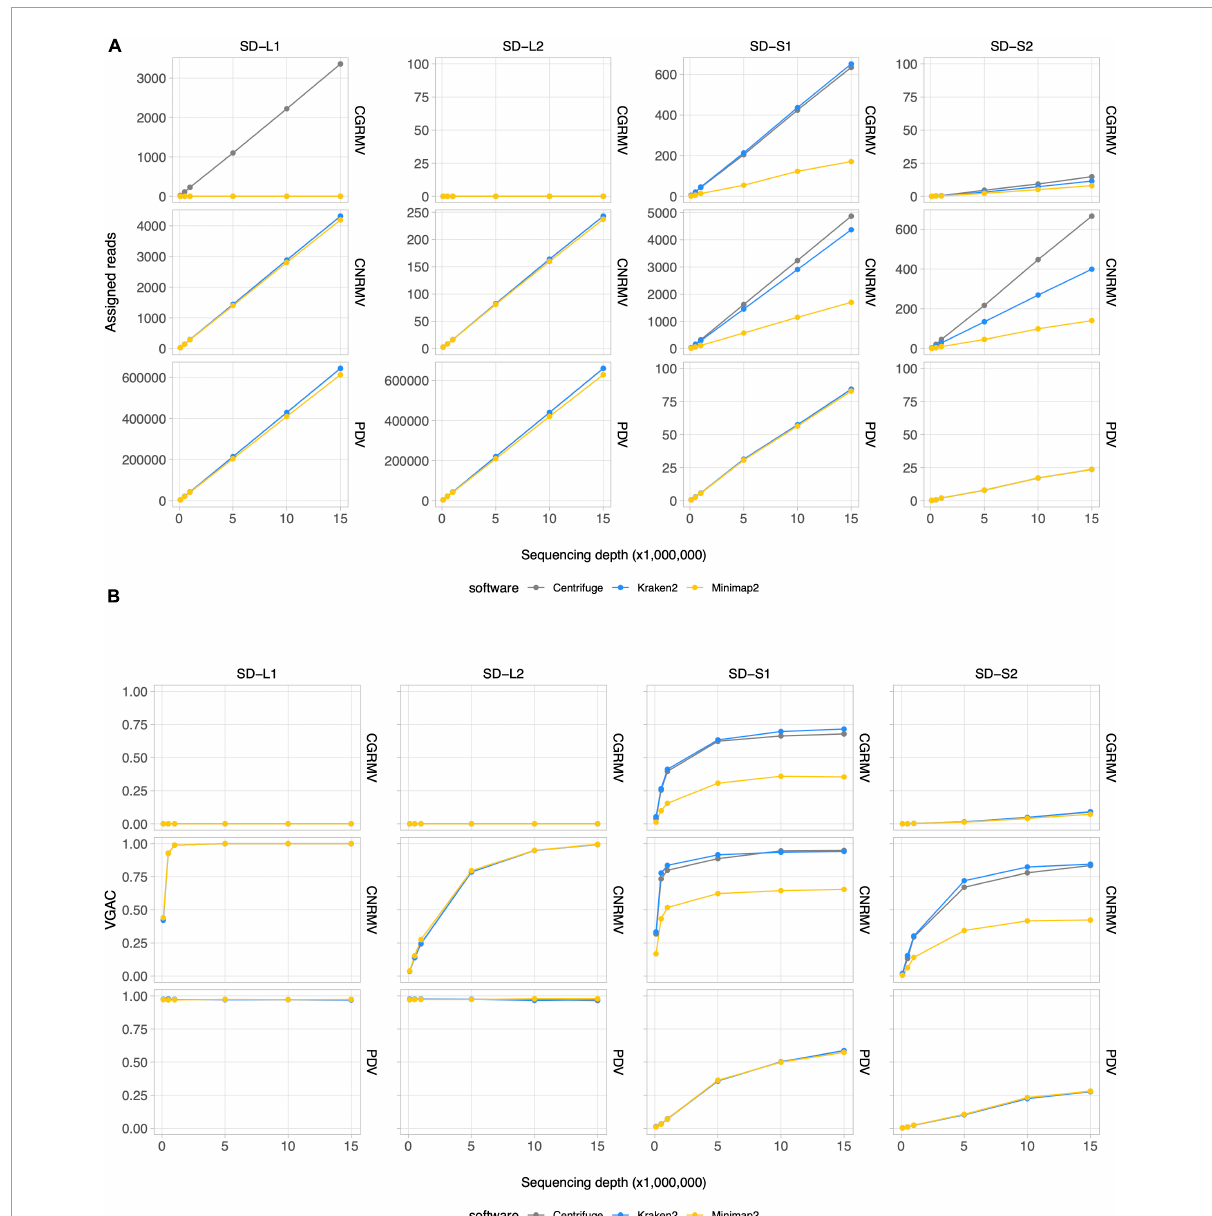
FIGURE2 Read assignment and assembly coverage with HTS data from field samples. Ten subsets of randomly selected reads from sequencing data for field samples of cherry plants at the shoot development stage (SD-L1, SD-L2, SD-S1, and SD-S2) were built at different depths of sequencing. Three bioinformatic algorithms were tested, namely Centrifuge , Kraken2 , and Minimap2 . All the dots represent the average of 10 measures. VGAC was calculated according to “Materials and methods” and with the reads assigned by the different algorithms at the respective depth of sequencing. (A) Read assignment at different depths of sequencing (note the different scales of the ordinates) using the Pavium panel-I. (B) VGAC obtained from the assembly of assigned reads (ranges from 0 to 1). Only the cases for CGRMV, CNRMV, and PDV are presented, but full versions containing all of the target viruses are depicted in Supplementary Figures 1 , 2 . Average values (dots) as well as standard deviations are listed in Supplementary Table 11 . SD, shoot development stage; VGAC, viral genome assembly coverage; CGRMV, cherry green ring mottle virus; CNRMV, cherry necrotic rusty mottle virus; PDV, prune dwarf virus.